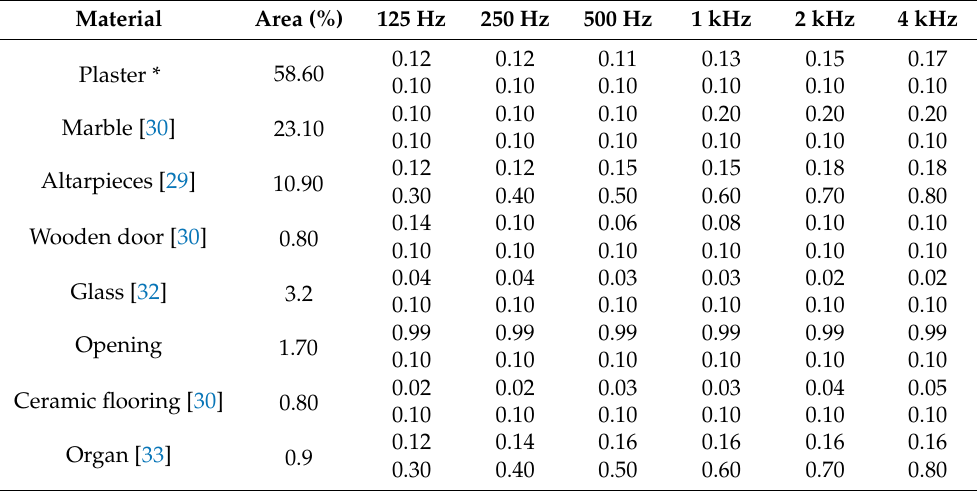
Table 5. Finishes: materials, references, surface (%), and absorption (up) and scattering (down) coefficients. * Material used for the adjustment.